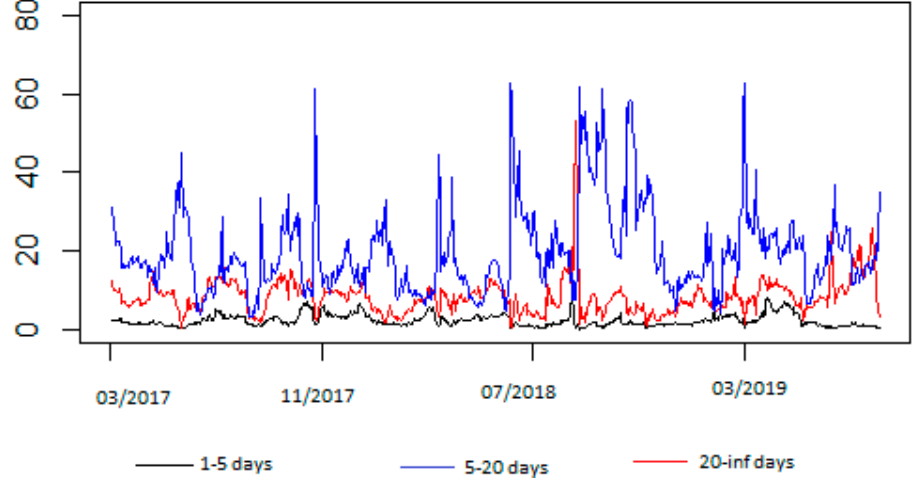
Figure 4. Frequency connectedness between bitcoin, gold, and crude oil return volatilities. Note: The frequency connectedness by Baruník and K ř ehlík (2018) with [1; 5] days in black, [5; 20] days in blue, and [20; 300] days in red. All lines through the frequency bands sum to the total connectedness.